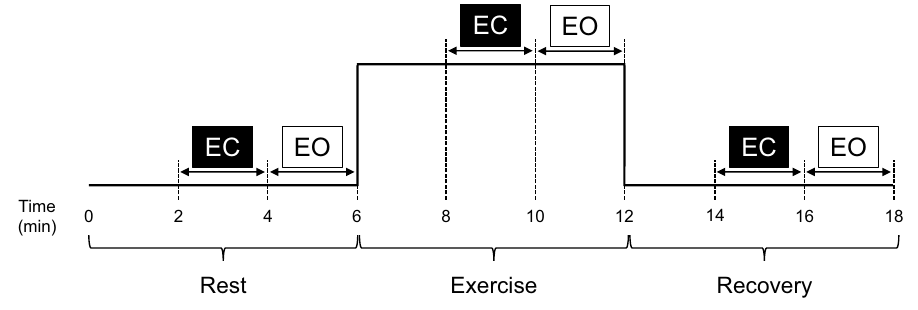
Figure 5. The experimental protocol. EC eyes closed, EO eyes